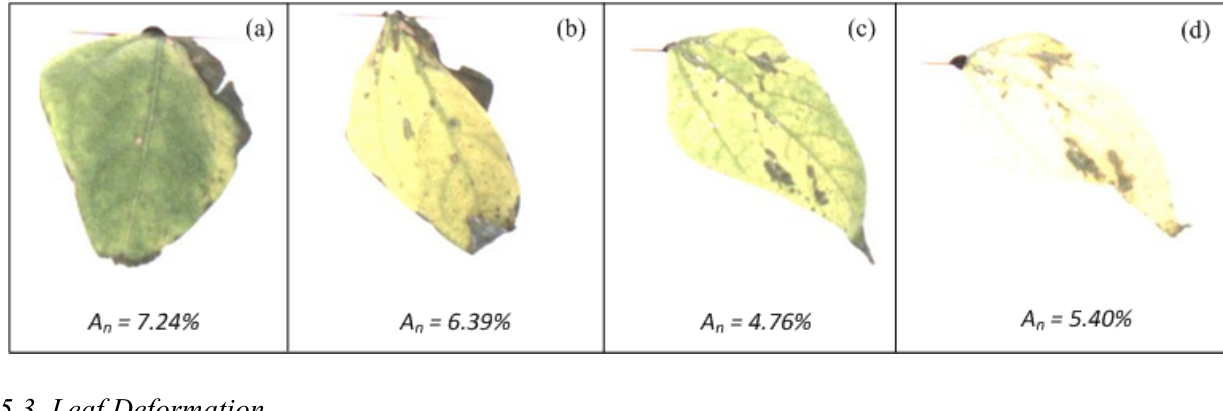
Figure 14. Bean and pepper leaves with different level of necrosis. ( a ) Bean leaf with necrotic and low-chlorotic areas. ( b ) Bean leaf with necrosis and high-generalized chlorosis. ( c ) and ( d ) Pepper leaves with necrosis and high-generalized